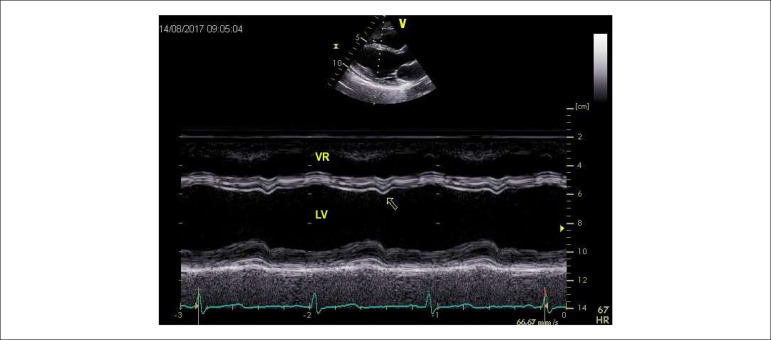
Two-dimensional echocardiography-guided M-mode showing abnormal
motion of interventricular septum (arrow) during chemotherapy
treatment. LV: left ventricle; RV: right ventricle.